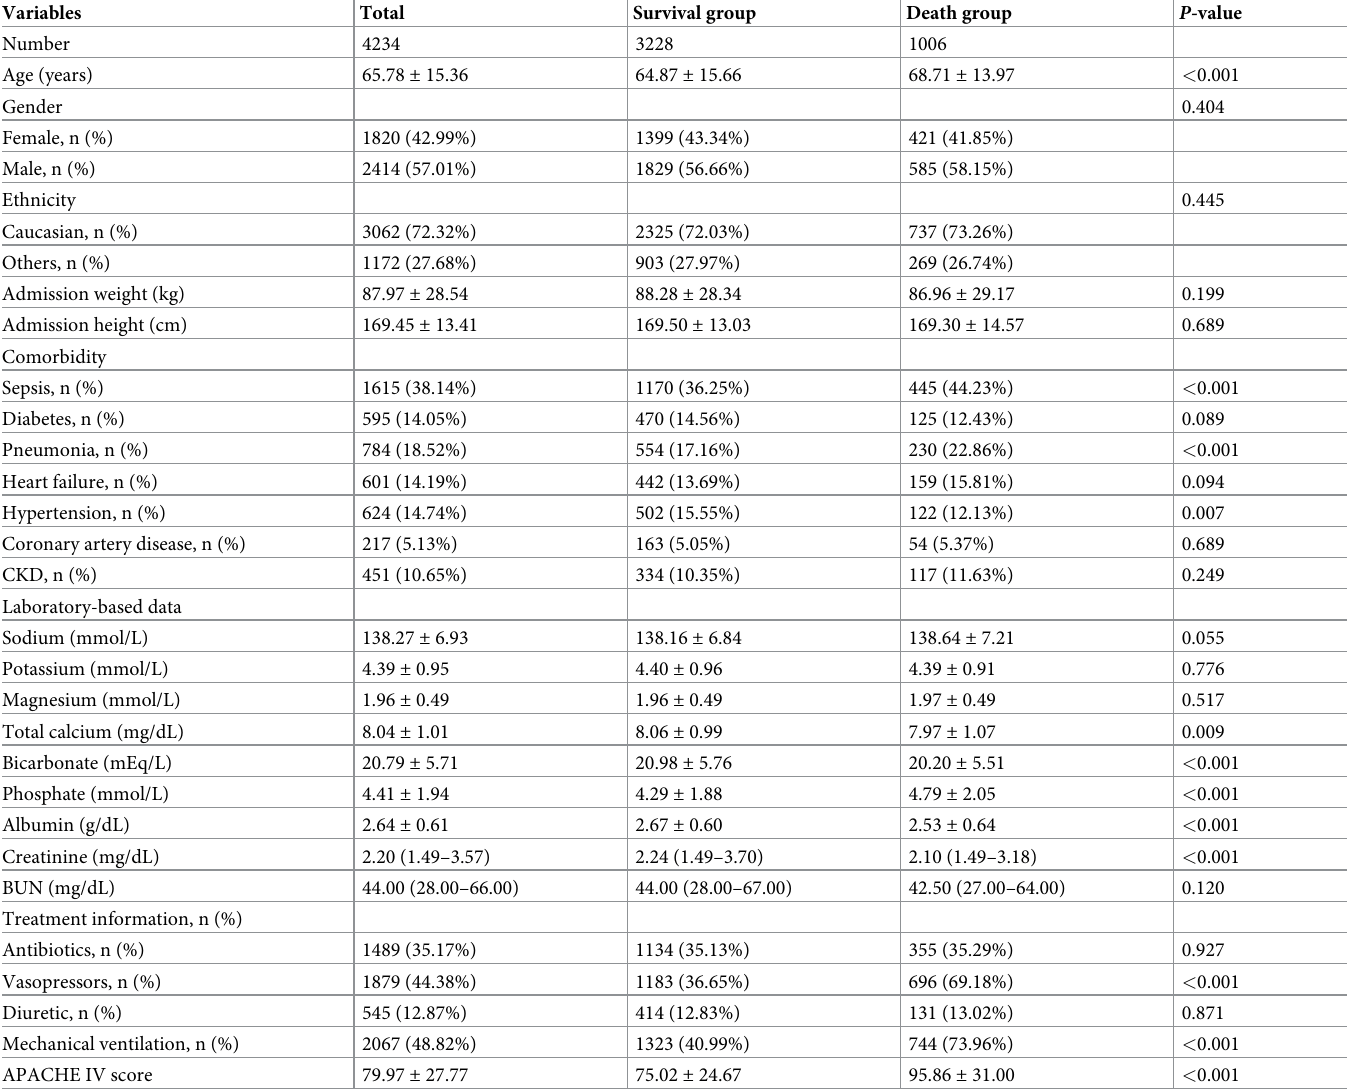
Table 1. Baseline clinical and laboratory characteristics of the study